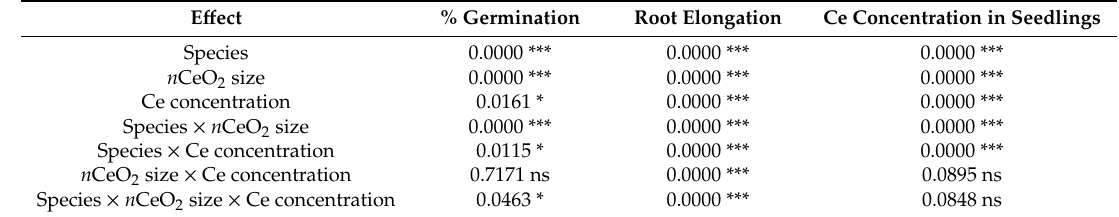
Table 3. Three-way ANOVA p values for the main e ff ects of plant species, n CeO 2 size and Ce concentrations and their interactions on the percentage of germination, seedling root length and Ce concentration in seedling of H. lanatus , L. flos-cuculi and D. tenuifolia . E ff ect % Germination Root Elongation Ce Concentration in Seedlings